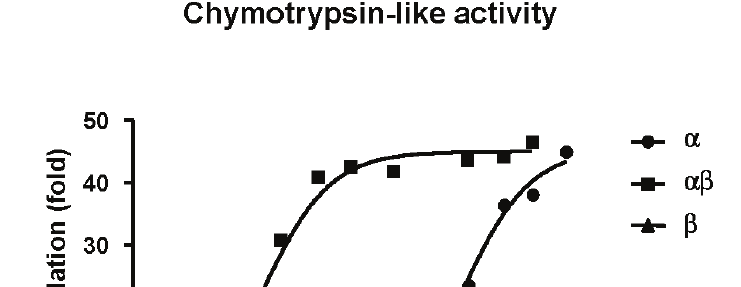
Figure 1. Effect of PA28(cid:2), PA28(cid:2)(cid:3) and PA28(cid:3) on the chymotrypsin-like activity of 20S immunoproteasome. Assays were carried out in continuo at 37 °C in 500 (cid:5)L of buffer reaction 20 mM Tris-HCl pH 7.5, 0.2% (w/v) BSA, containing 100 (cid:5)M of Suc-LLVY-AMC. For each assay, 4 ng of 20S were